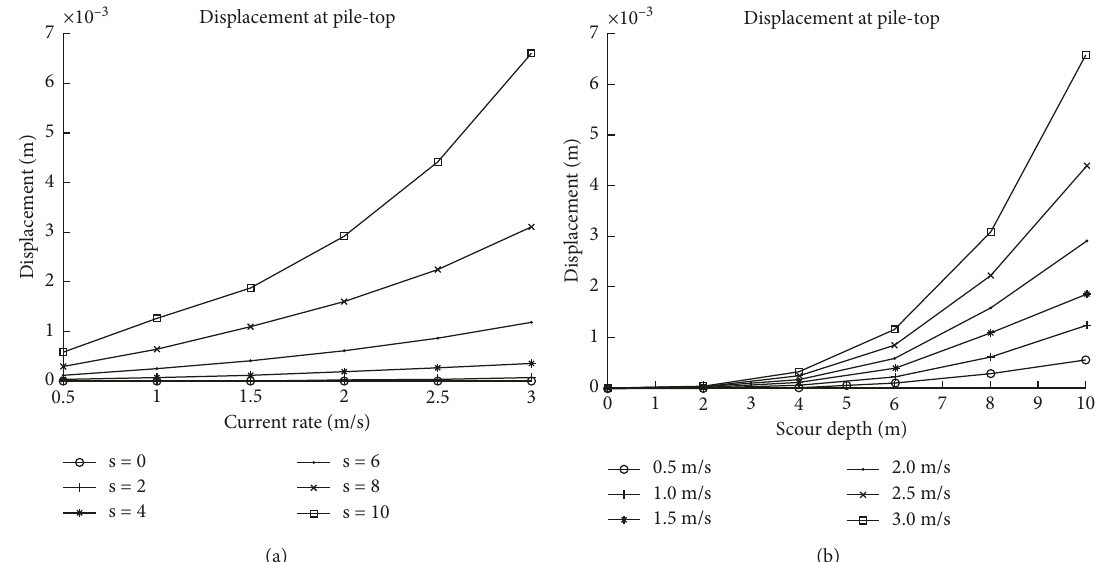
Figure 13: Structural displacement at the pile top under different conditions. (a) Flow velocity. (b) Scour